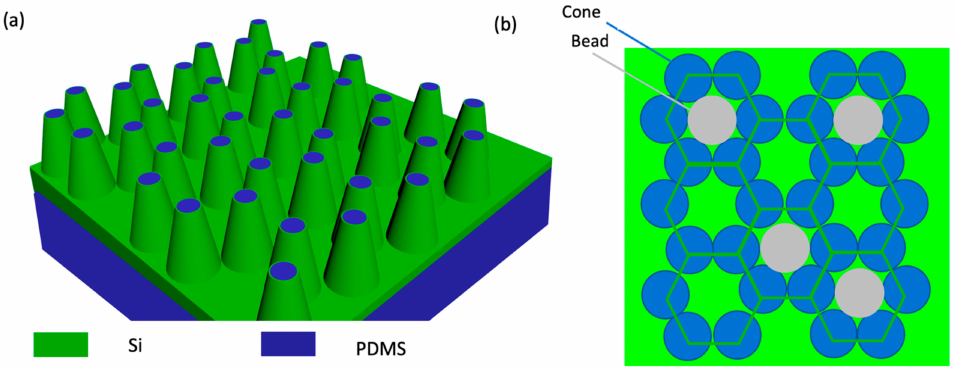
Figure 4. Nanocone array structure ( a ) Illustration of honeycomb-cone array structure. ( b ) Illustration of vacant cell center in order to locate the magnetic